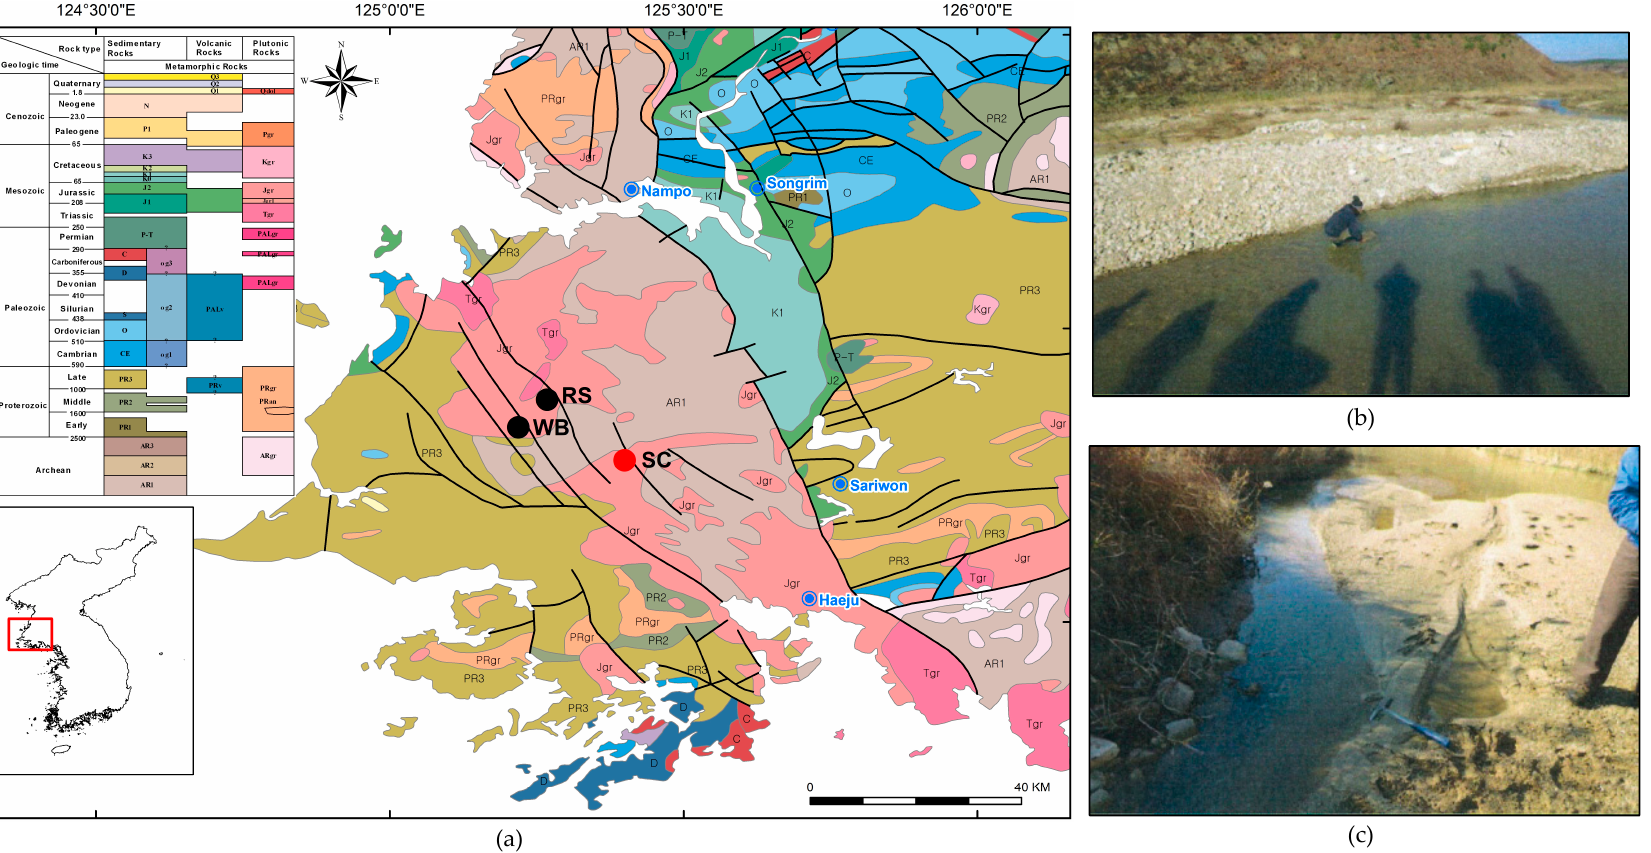
Figure 1. The geological map of the Sam-Cheon area ( a ) [16] and photographs of sampling location of feed sample ( b , c ). WB—Wolbong mine; RS—Ryeonsan mine; SC—Sam-Cheon area.